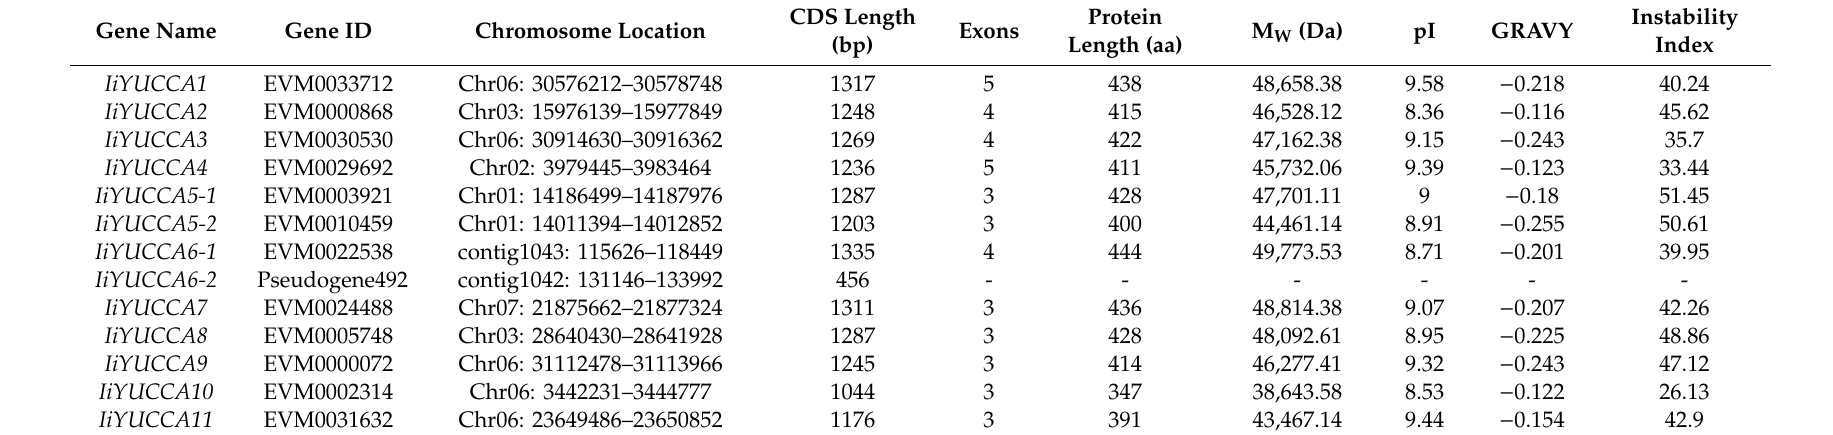
Table 1. YUCCA family genes in I. indigotica